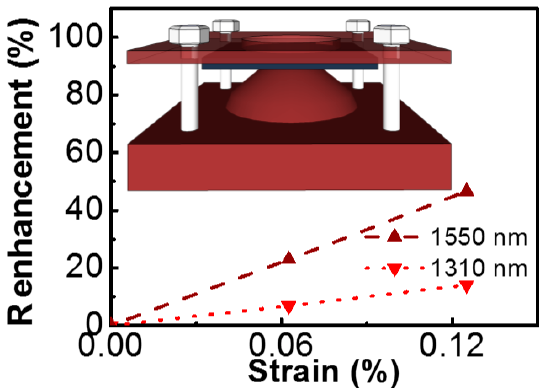
Figure 3. The responsivity ( R ) enhancement versus degree of mechanical strain applied on the thin-film Ge detector. The responsivity is calculated from the − 2 V data. The inset shows the schematic set-up to apply mechanical strain.